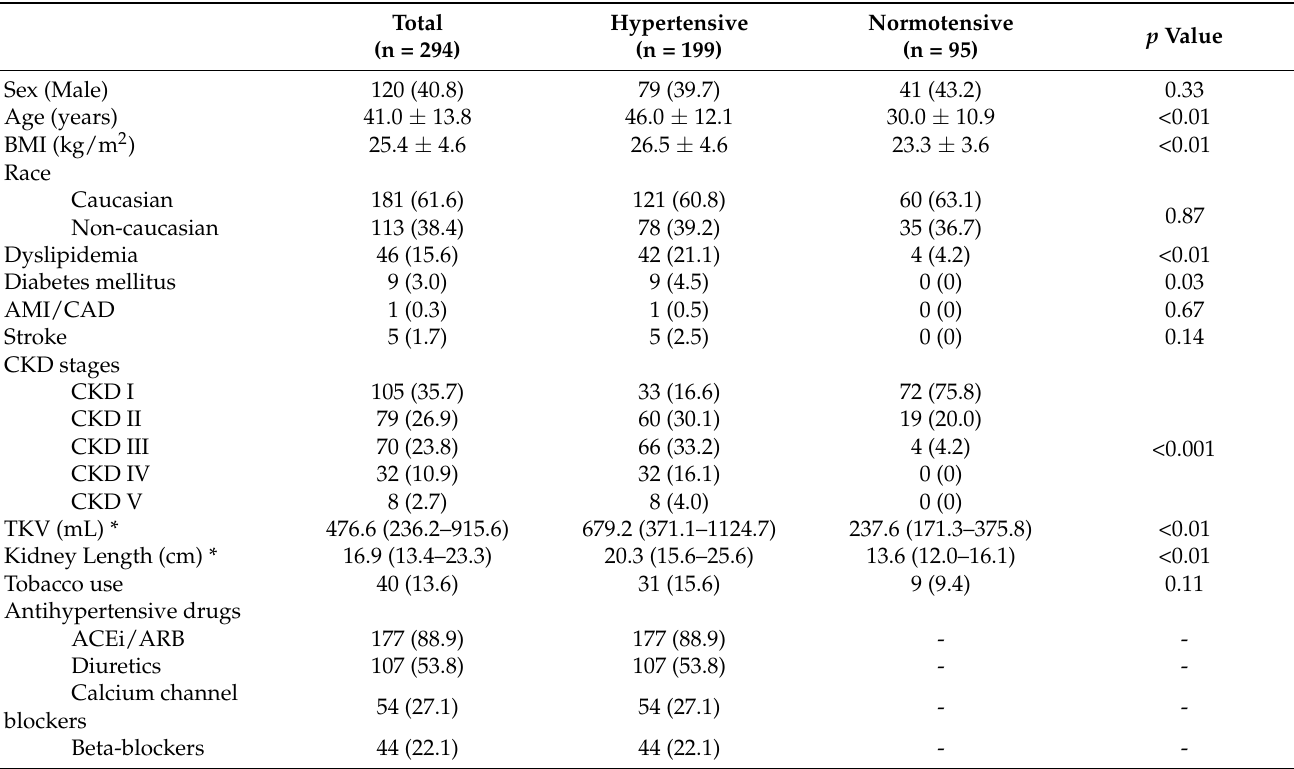
Table 1. Demographic and clinical characteristics in ADPKD patients.